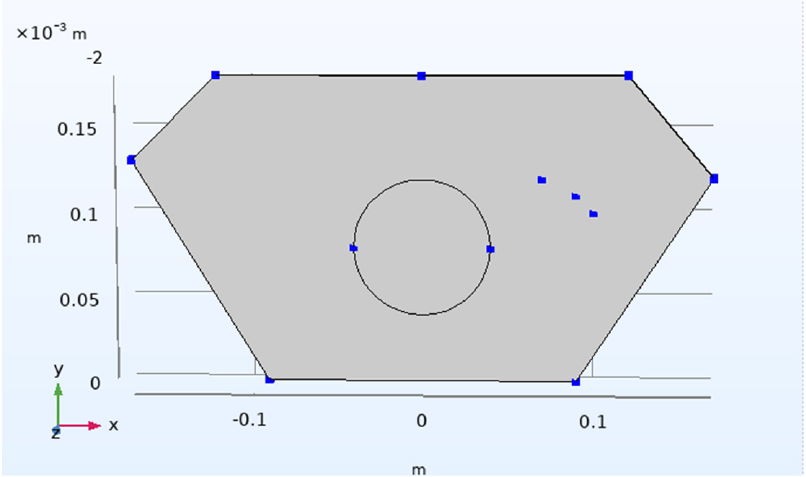
Figure 10. The Comsol Johnson-Cook model predicts a graph of 8 node locations.